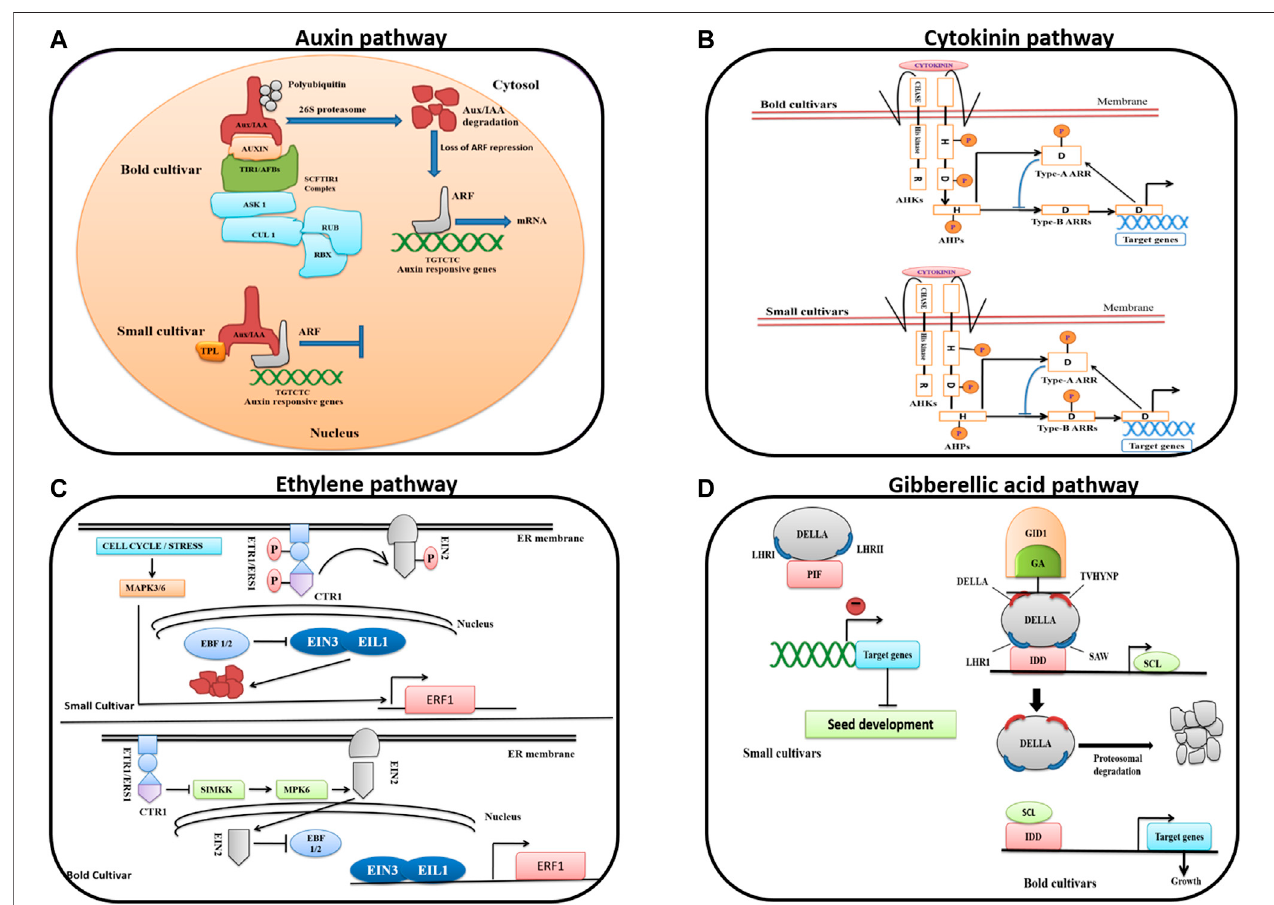
FIGURE 8 | Phytohormone pathways important for seed development are represented in two contrasting genotypes of ricebeans on the basis of their expression and involvement in the enriched KEGG pathways. (A) Auxin signaling pathway. (B) Cytokinin pathway. (C) Ethylene pathway. (D) Gibberellic acid